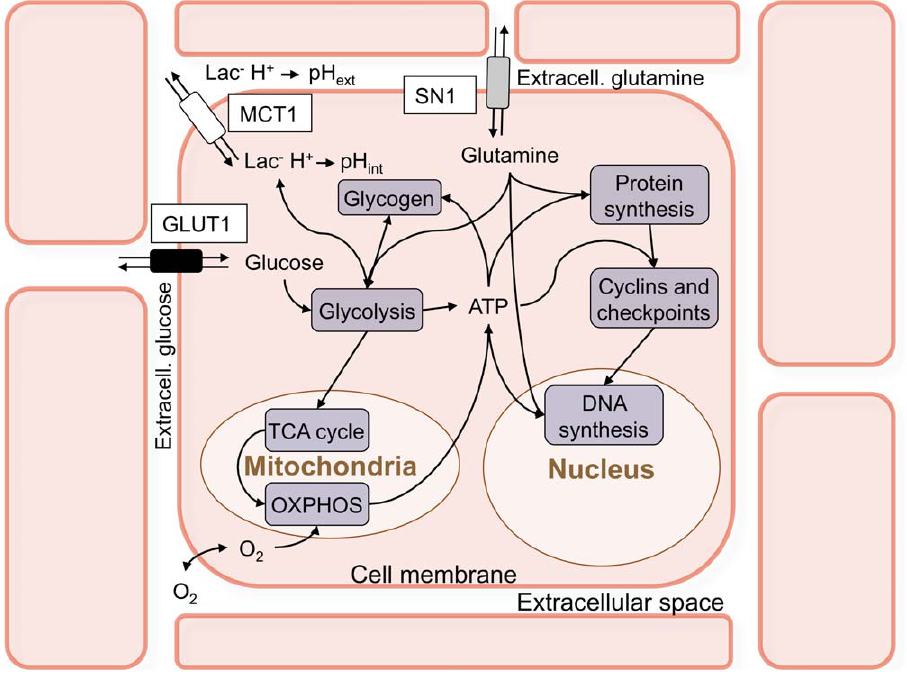
Figure 1. Rough sketch of the biochemical pathways incorporated in the model of single cells. We take into account the main metabolic pathways (glycolysis, oxidative phosphorylation through the TCA cycle and gluconeogenesis), including the role of mitochondria in the production of ATP. The model also includes protein and DNA synthesis, and checkpoints controlled by representative members of the cyclin family. The single-cell model has two spatial compartments (the inside of the cell and its immediate neighborhood, the extracellular space that surrounds it) and transport of substances between these compartments is regulated by transporters on the cell membrane that are also included in the model. The extracellular space of each cell communicates by simple diffusion with the neighboring extracellular spaces and with the environment. The complete map of the biochemical pathways is shown in figure S2.